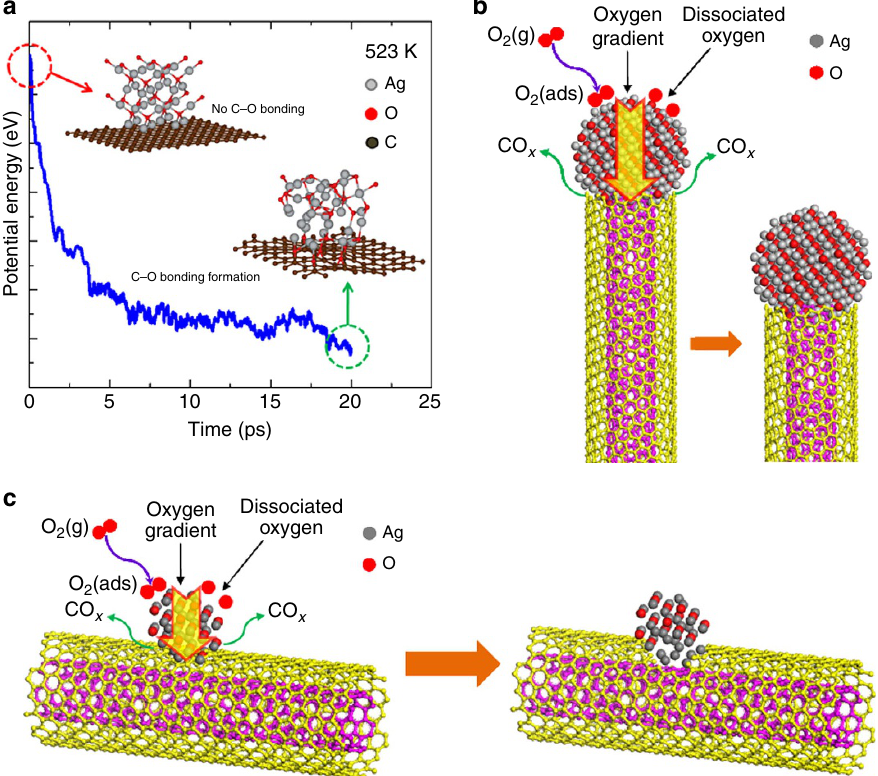
Figure 5 | Sketch map of the oxidation process. ( a ) Ab initio molecular dynamic simulation result. Here we use Ag 2 O with a graphene support. The two insets were extracted from the simulation process. One is from the initial time marked by the red dashed circle and the other one is the final state after the C–O bonds formation marked by the green dashed circle. ( b ) The sketch map of the oxidation process for the case that the NP decorated the tip of the CNTs, while c shows the case the NP decorated the external surface of the CNTs, the yellow arrows in b and c show the oxygen concentration